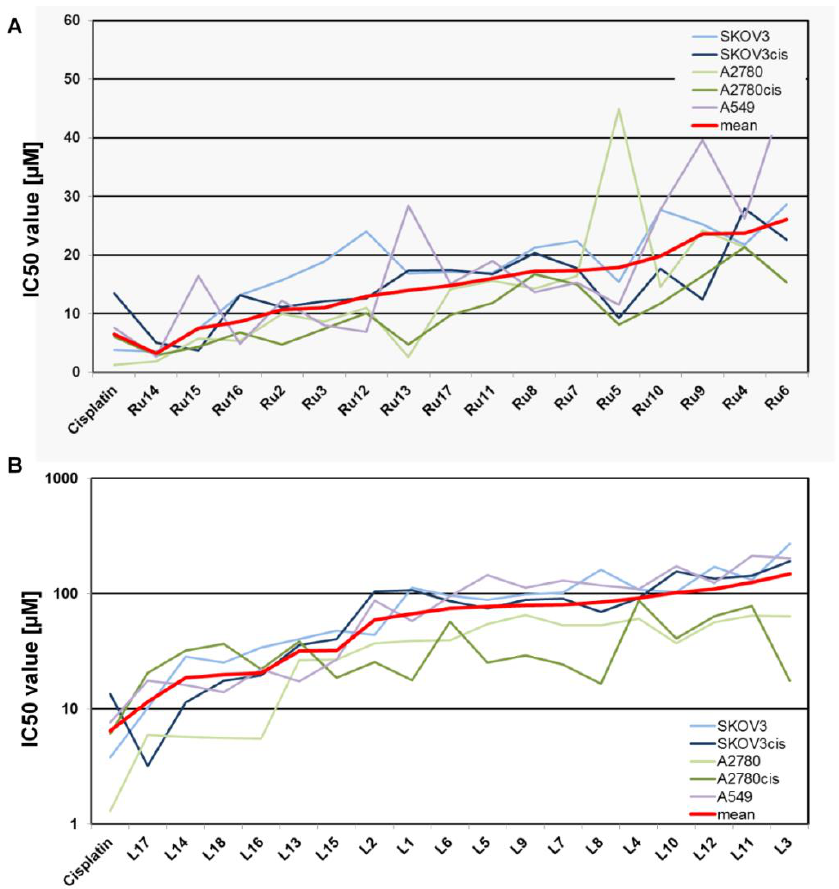
Figure 5. Trend of IC50 values for all Ru(II) compounds ( A ) and β -Hydroxydithiocinnamic acid alkyl esters ( B ) for investigated cell lines ordered by the mean IC50 value (red line).